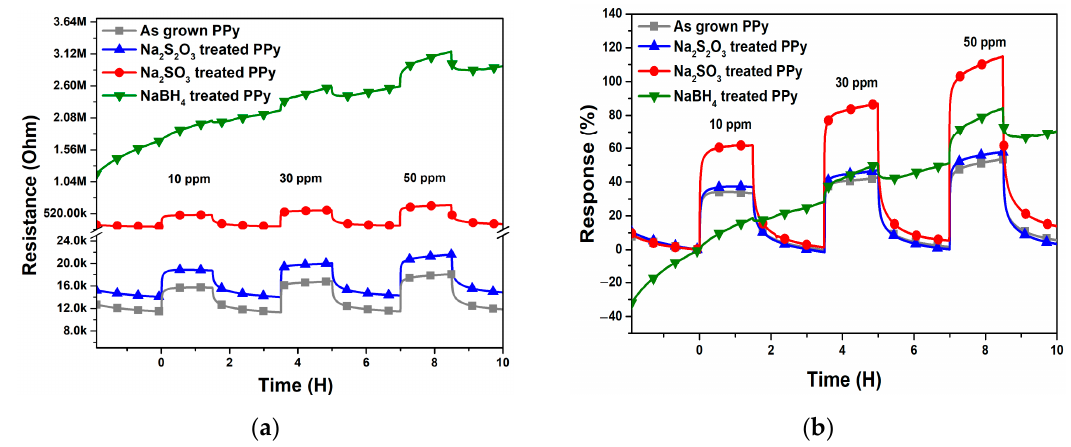
Figure 8. Ammonia sensing test: ( a ) electric resistance changes and ( b ) response of the as grown PPy sensor and PPy sensors after reduction treatments in Na 2 S 2 O 3, Na 2 SO 3 and NaBH 4 10 wt% solution in demineralized